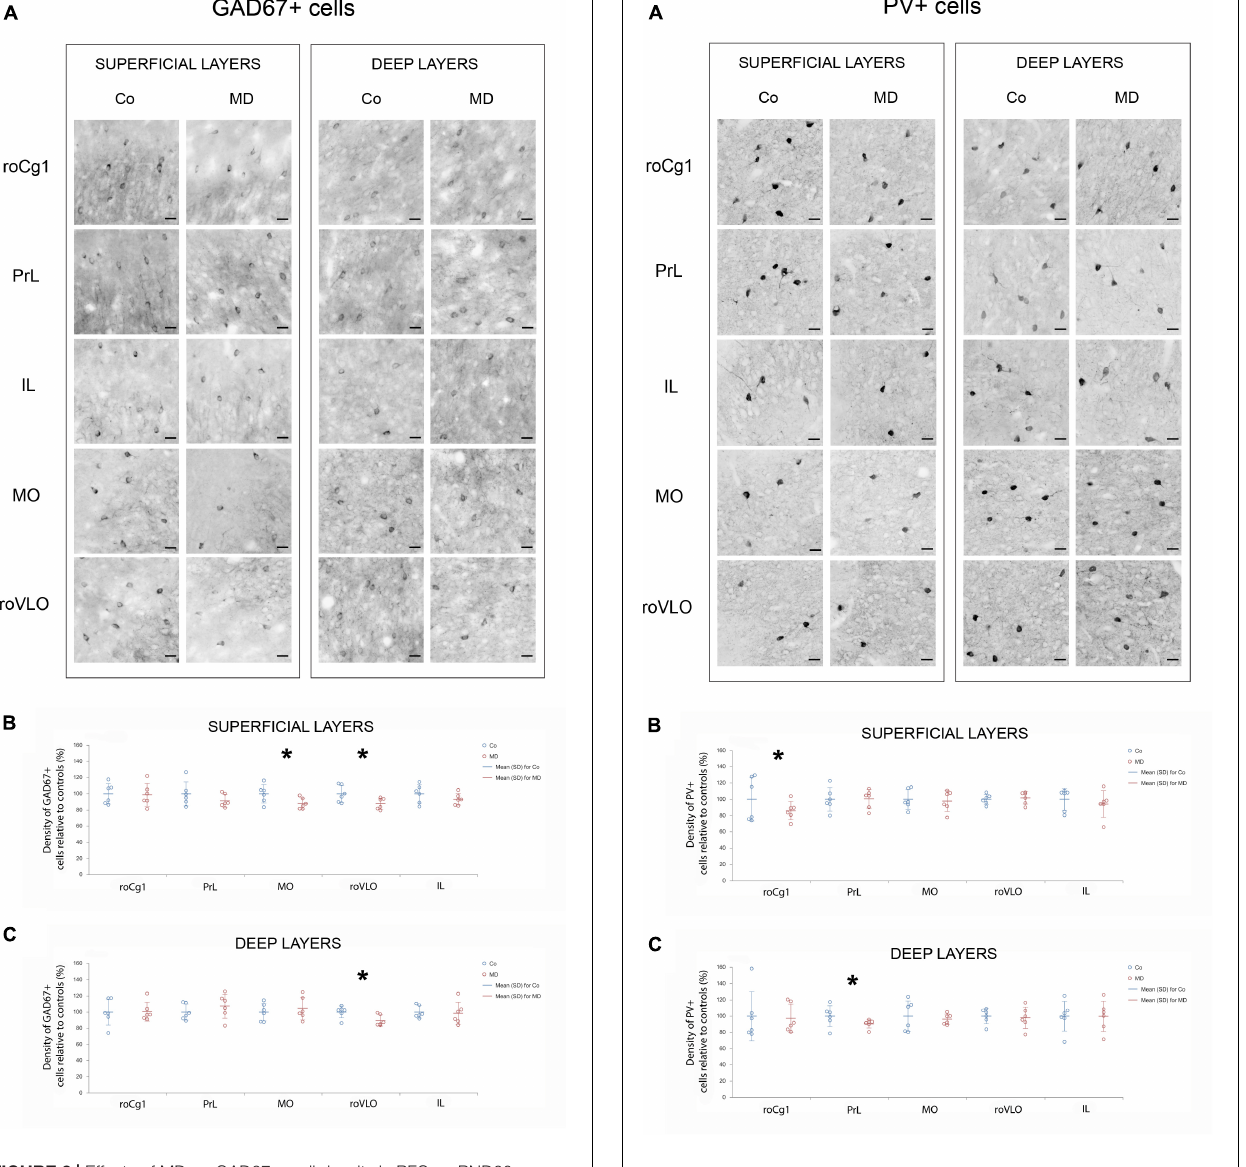
FIGURE 3 | Effects of MD on PV + cell density in PFC on PND60. Representative photomicrographs of PV + immunohistochemistry (A) . Dot plot graphs in (B,C) representing quantification of the results as means ± SD (horizontal bars) and observed values (dots), n = 6 per group in superficial and deep layers of the respective PFC area. MD rats had lower PV + cell density in the superficial layers of Cg1 (B) and deep layers of PrL (C) . * p < 0.001 Co vs. MD. roCg1 rostral part of area 1 of cingulate cortex, Co control, IL infralimbic cortex, MD maternally deprived rats, MO medial orbital cortex, PrL prelimbic cortex, roVLO rostral part of the ventral lateral orbital cortex. Scale bars in (A) correspond to 25 µ